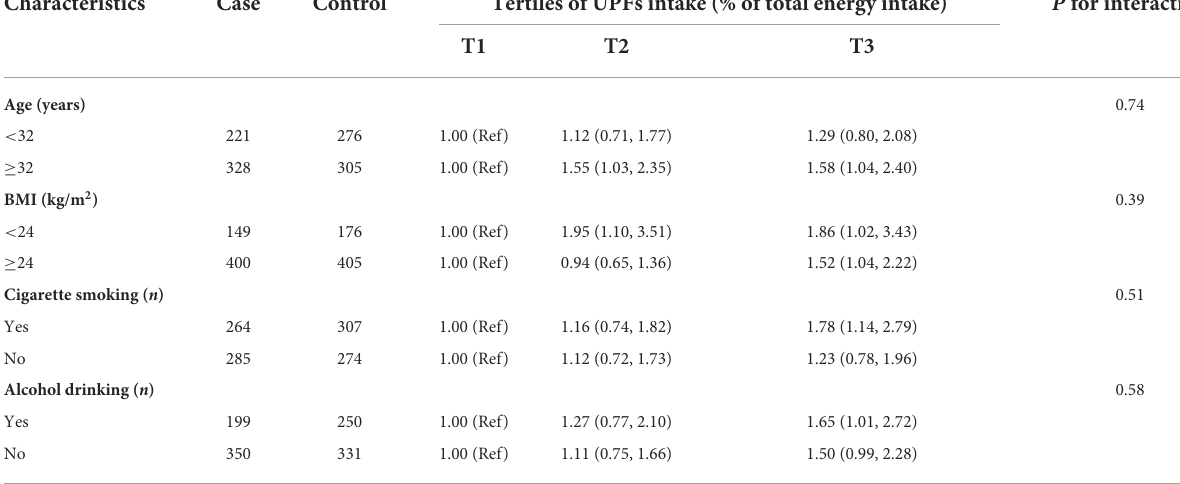
TABLE 3 Adjusted odds ratio (95% confidence interval) of ultra-processed foods intake and asthenozoospermia stratified by age, BMI, cigarette smoking, and alcohol drinking.